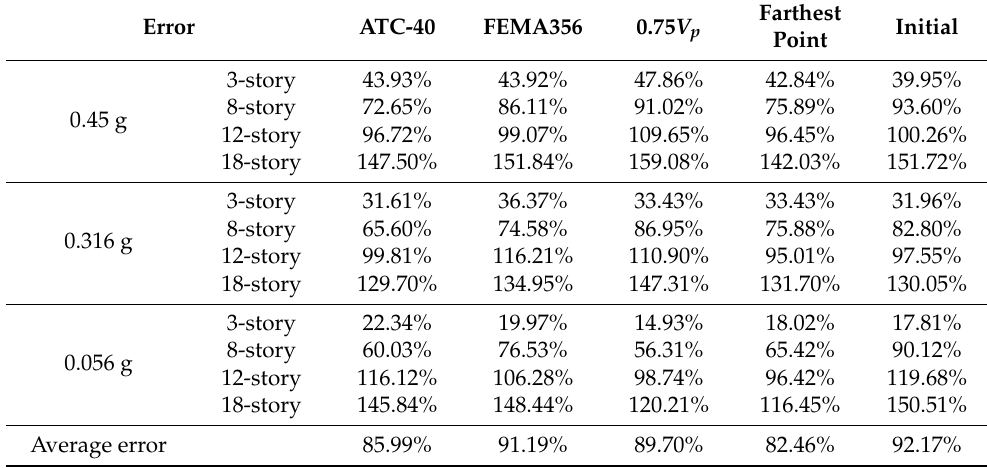
Table 5. Errors of calculated story accelerations (average value of all the